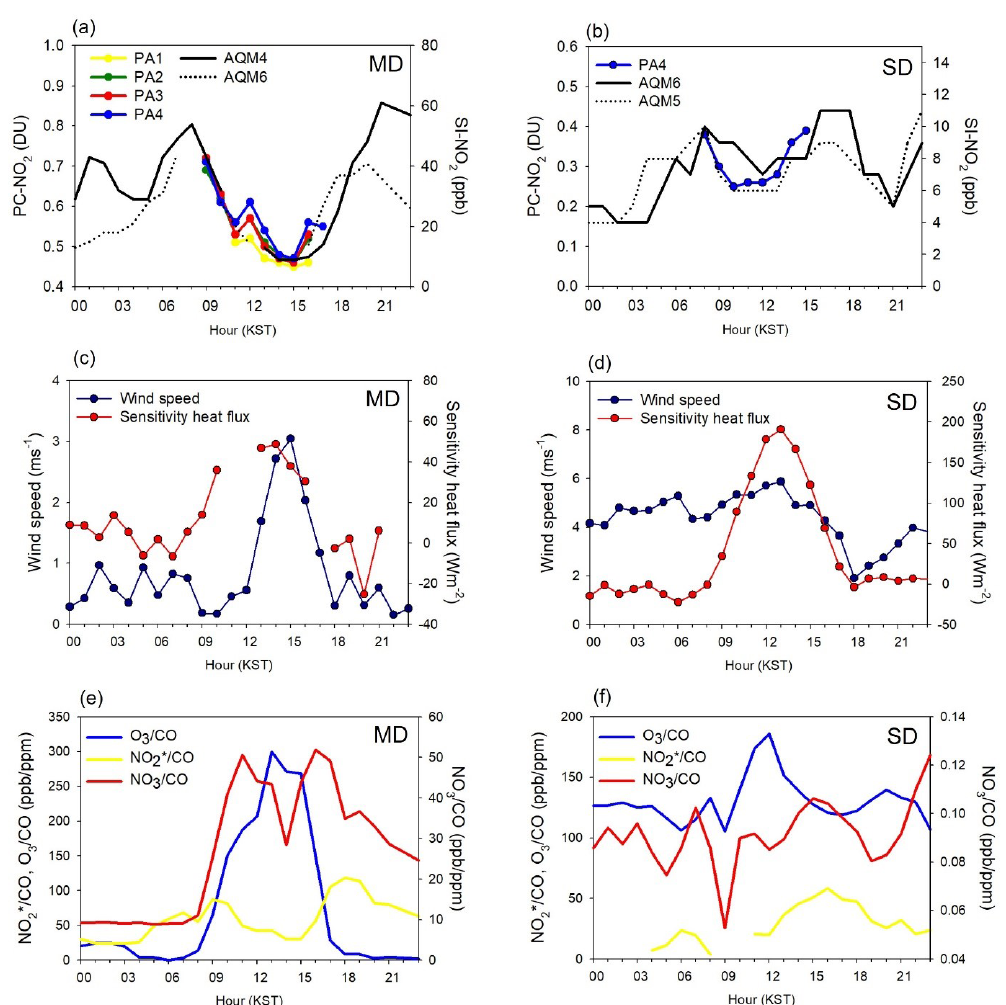
Figure 11. Examples of the diurnal variation on 25 November (a, c, e) and 14 December (b, d, f) . (a, b) Column NO 2 at sites PA 1 –PA 4 , and surface NO 2 at air quality monitoring sites AQM 4 and AQM 6 . (c, d) Sensible heat fluxes and surface wind speed at PA 4 . (e, f) Diurnal variation in NO 2 , NO − , and O 3 normalized by CO. Figure 1 shows the locations of the measurement 2